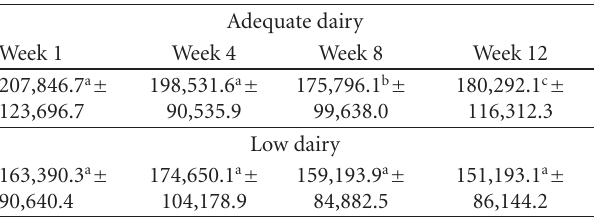
Table 6: Energy expenditure and physical activity characteristics in adult women and men consuming adequate dairy (AD) or low- dairy (LD) diets for 12 weeks on a caloric-restricted diet.